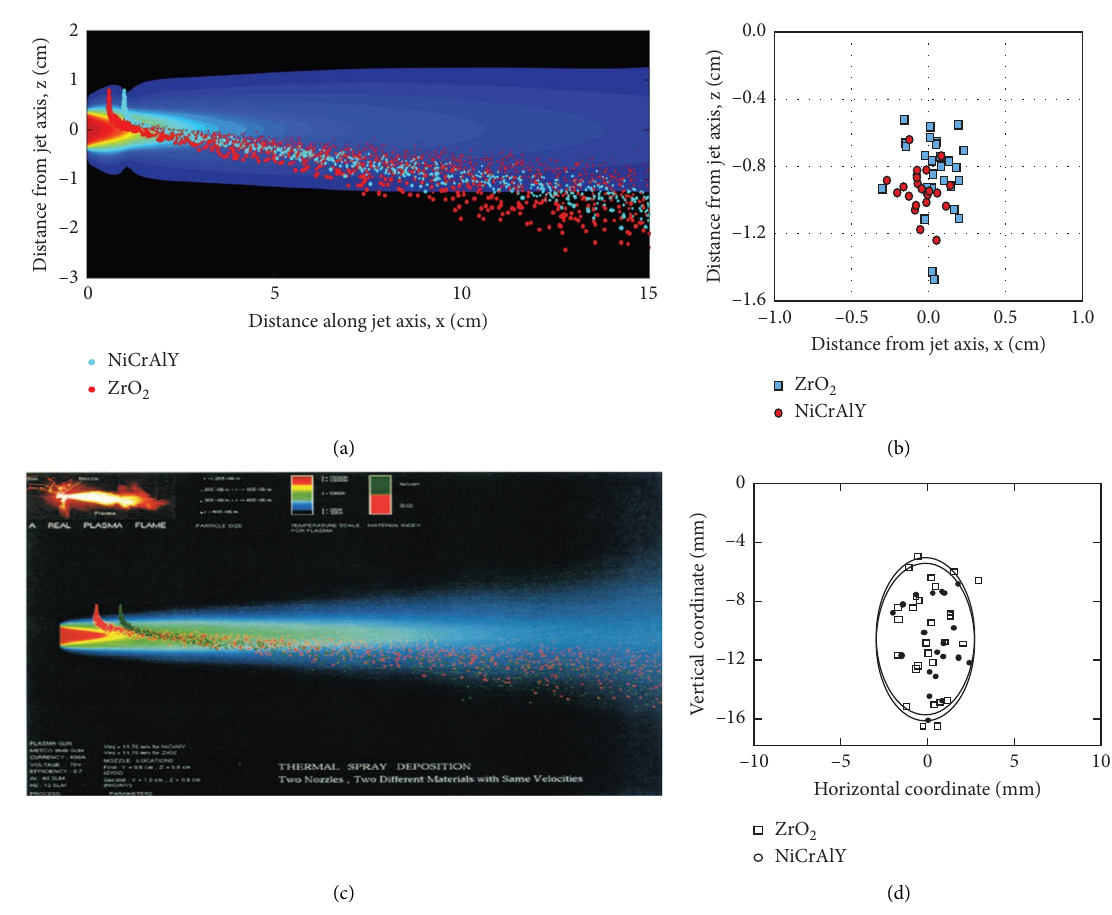
Figure 4: Computed instantaneous distributions (at � 5ms after the start of the injection of particles) of the NiCrAlY (red color) and the ZrO 2 (blue color) particles in the yz-plane and the xz-plane: (a) (b) present results, (c) (d) Wan et al.’s results. In both cases, the NiCrAlY and the ZrO 2 injectors are located at (10, 8) mm and (6, 8) mm, respectively. Particles injected at the same injection velocity of 11.7m/s and the carrier gas fow rate of 5slm and are collected in the observation window, 9.9 ≤ y ≤ 10.1 cm. Table 1: Injector locations, particles’ injection speed, particles’ mean z -location, and the mean axial velocity and temperature of particles when they arrive at the substrate. Values of other parameters are: current � 500A, voltage � 50 V, Ar fow rate � 40slm, H 2 fow rate � 10slm, particles’ diameter between 30 and 100 μ m, mass fow rates of NiCrAlY and ZrO 2 � 20g/min, and z -locations of powder ports � 8mm. Injection